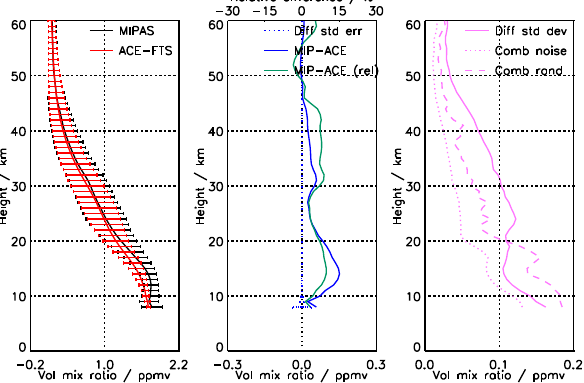
Figure 1. Comparison of CH 4 from ACE-FTS and MIPAS reduced resolution (V5R_CH4_225 and V5R_CH4_224). Left panel: mean profiles of MIPAS (black) and its standard deviation (horizontal bars) and of ACE-FTS (red) and its standard deviation (horizontal bars). Middle panel: mean difference MIPAS minus ACE-FTS (blue solid), standard error of the difference (blue dotted), mean relative difference MIPAS minus ACE-FTS relative to ACE-FTS (green, up- per axis). Right panel: combined mean estimated statistical error of the difference (pink dotted, contains MIPAS instrument noise error only), combined mean estimated statistical error of the difference (pink dashed, contains MIPAS example random error budget), stan- dard deviation of the difference (pink solid).